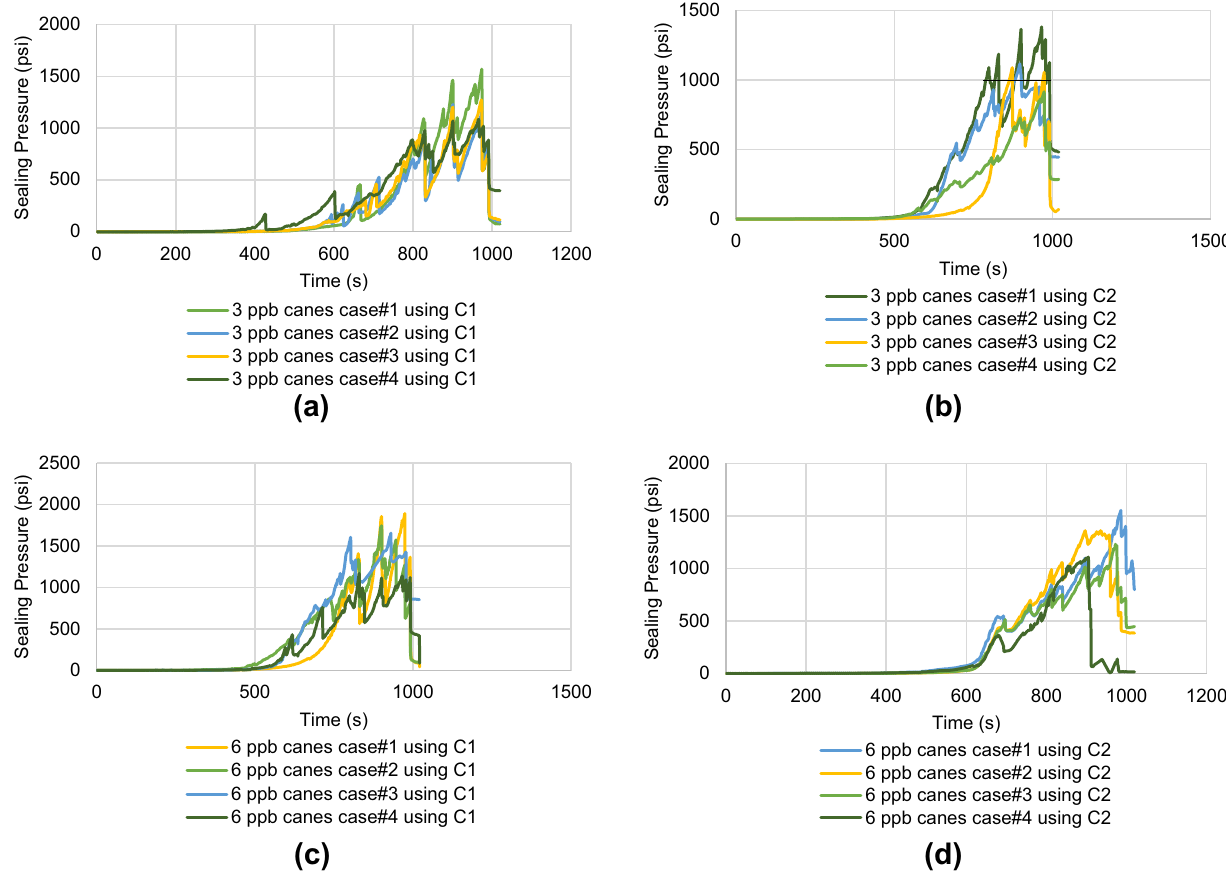
Fig. 19 HPA Pressure versus Time plot for 3 & 6 ppb Canes showing maximum sealing pressure at different cases using C1 and